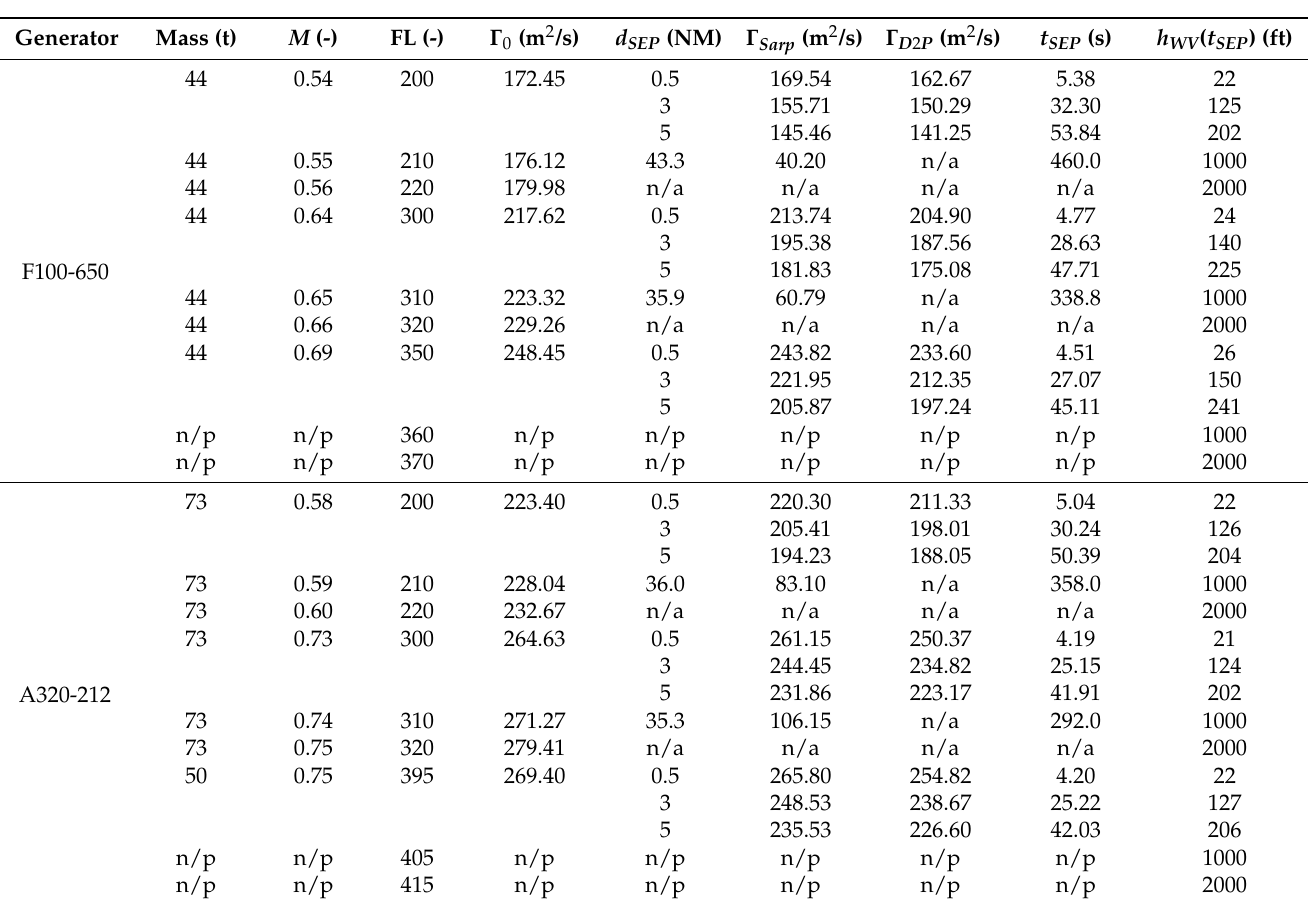
Table 3. Maximum circulations of wake vortex encountered by aircraft behind several generator aircraft in realistic scenarios, and flight conditions of the